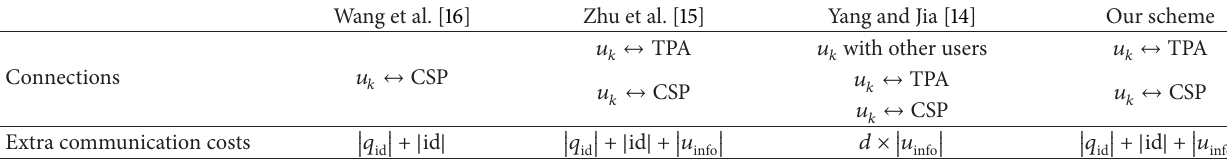
Table 1: Connections and communication costs for updating a data block.